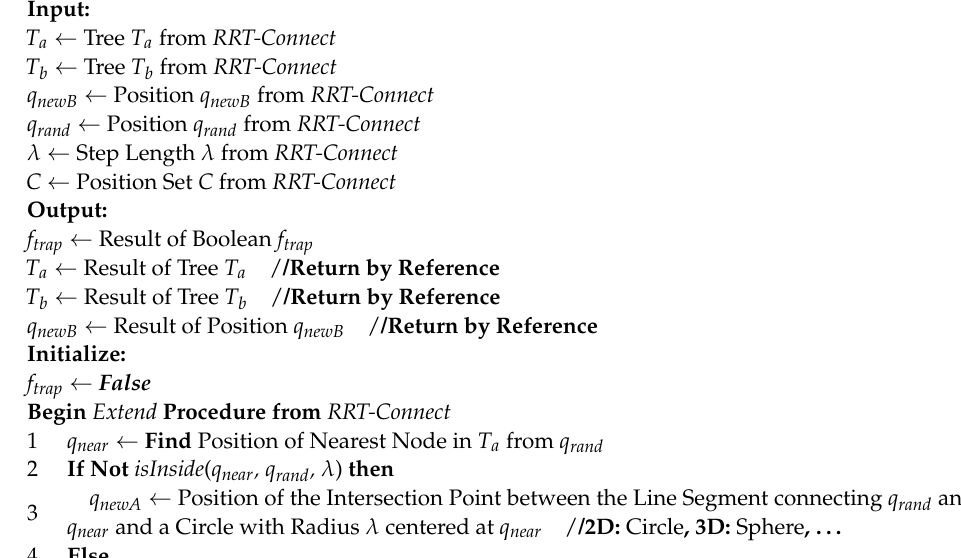
Algorithm 2 Pseudocode of the original ‘Extend’ method from the RRT-Connect